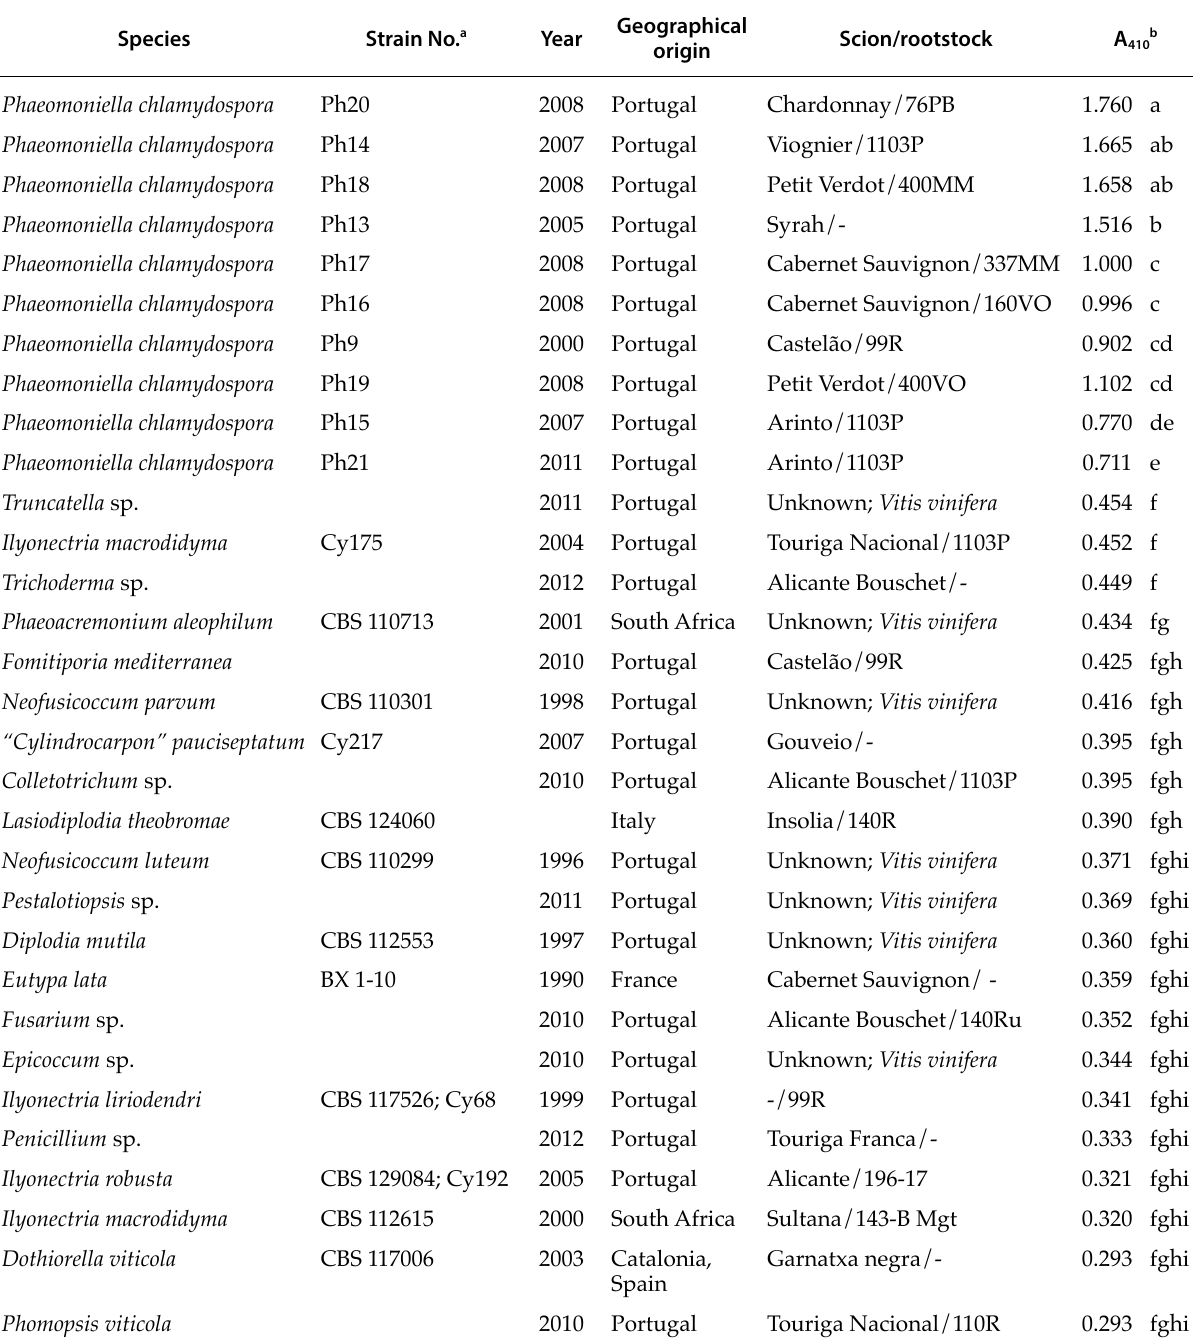
Table 1. Absorbance values (A 410 ) for fungal species and isolates, in a test for reactivity and cross-reactivity of a monoclonal antibody (mAb116) produced against Phaeomoniella chlamydospora